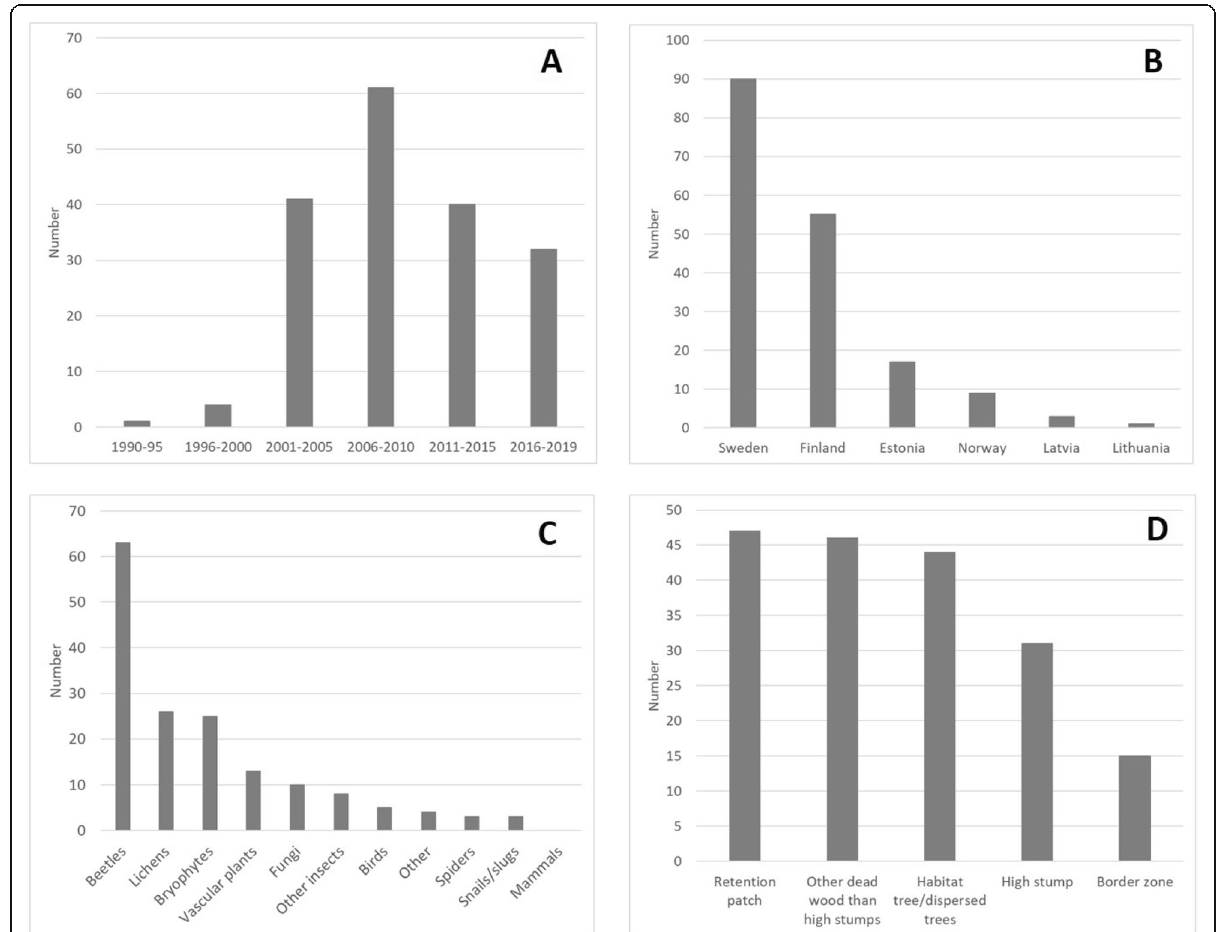
Fig. 1 Classification of articles from the systematic literature search on biodiversity and retention forestry in Sweden, Finland, Norway, and the Baltic states, conducted in Web of Science August 2019, using pre-defined search strings. A = year published, B = country, C = organism group, D = type of